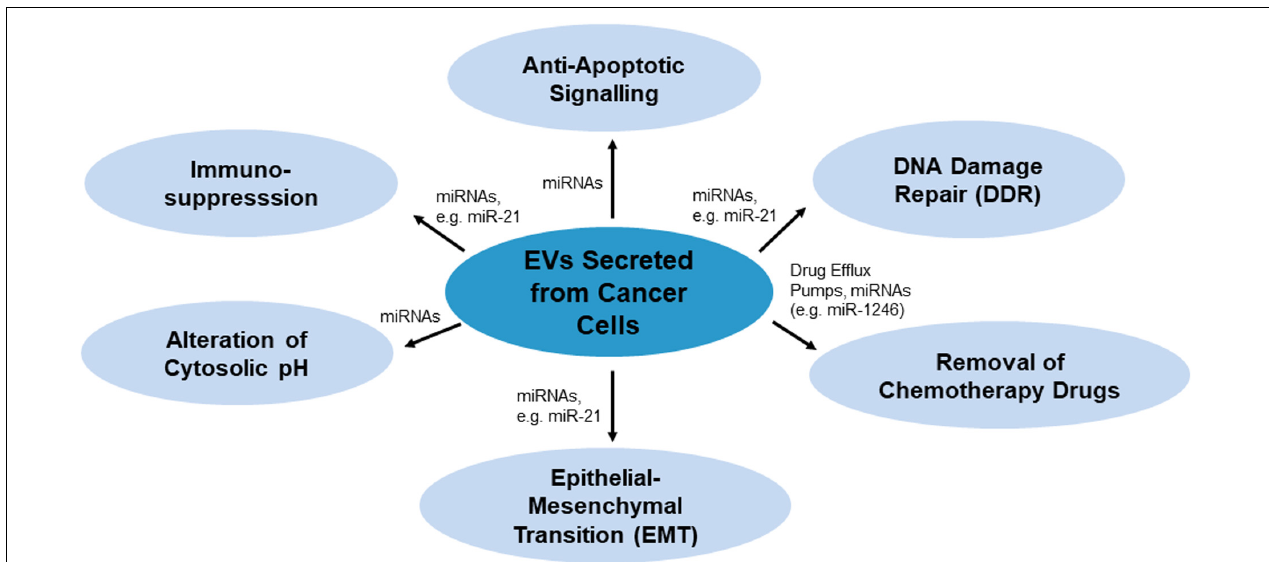
FIGURE 1 | Mechanisms of EVs-mediated chemoresistance miRNAs or proteins such as drug efflux pumps as the key players carrying drug resistance